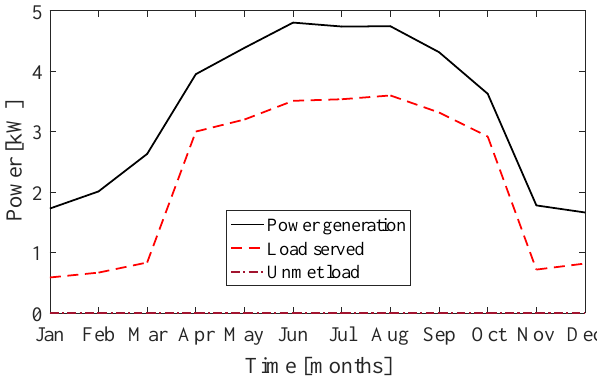
Figure 5. Total power generation, total electrical load served and unmet electrical load (average